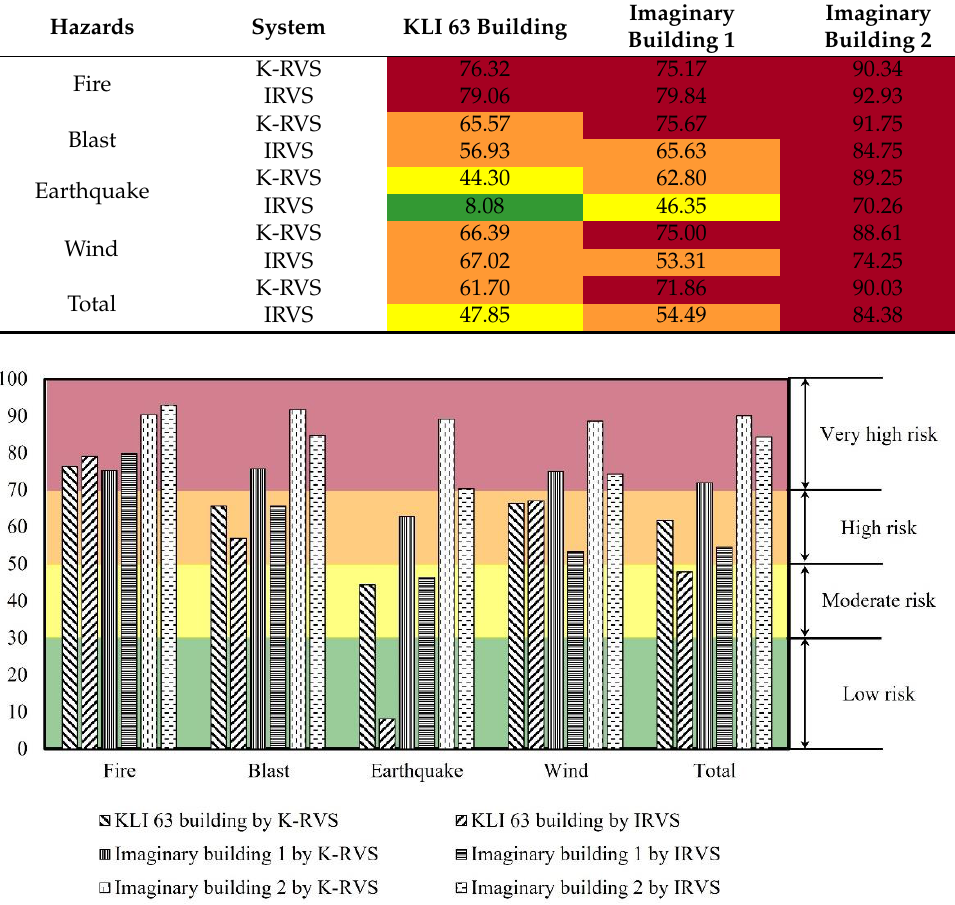
Figure 4. Score by each hazard and final score from K-RVS and